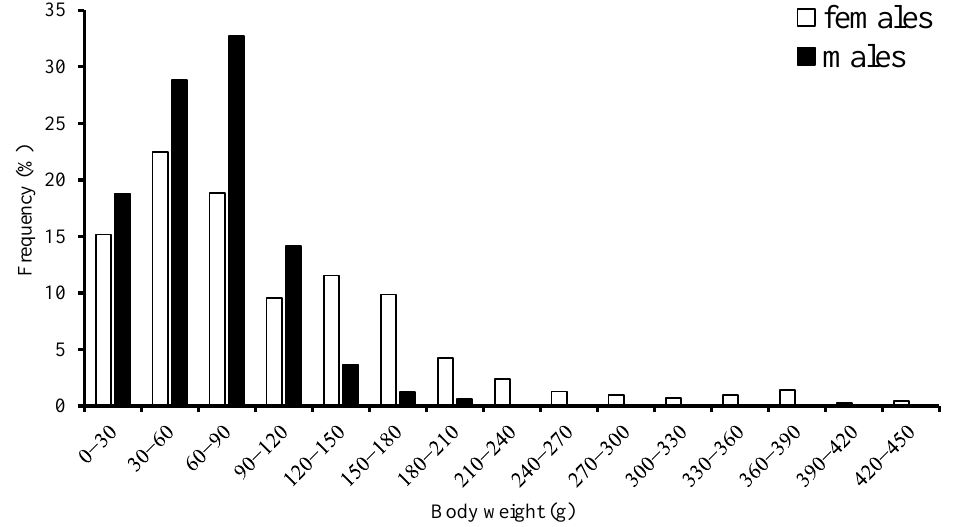
Figure 3. Frequency distribution of body weight for S. oualaniensis in the waters of the Xisha Islands of the South China Sea.